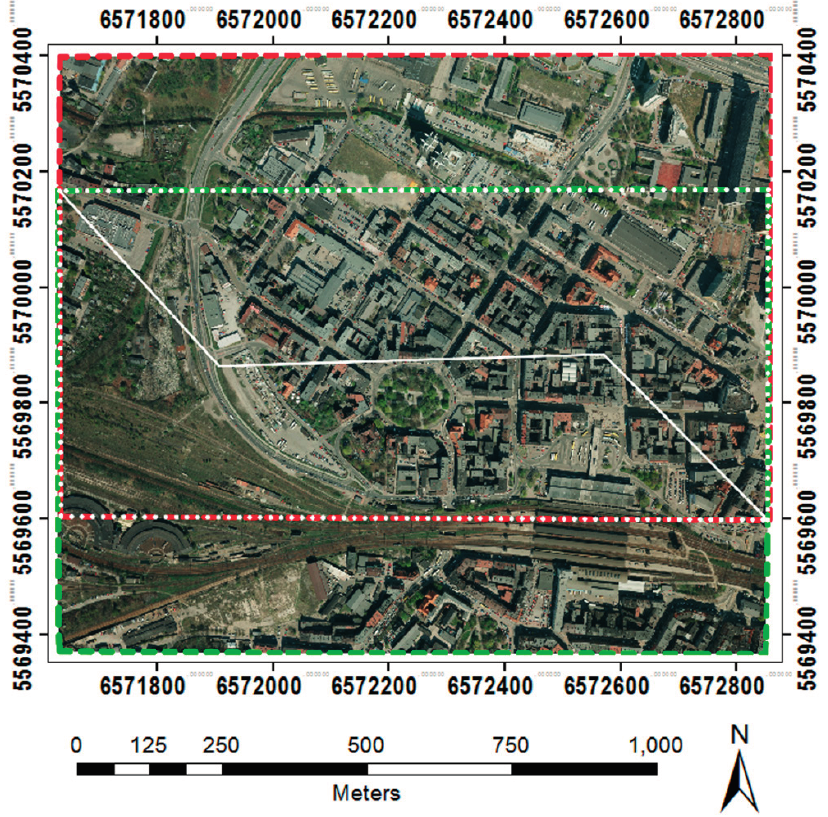
Figure 5. Determining the overlapping areas among DOMs and the extraction of the straight skeleton for the overlap. The red dashed line is the effective area of the top DOM. The green dashed line is the effective area of the bottom DOM. The white dotted line is the overlapping area between two DOMs. The white solid line is the extracted straight skeleton.